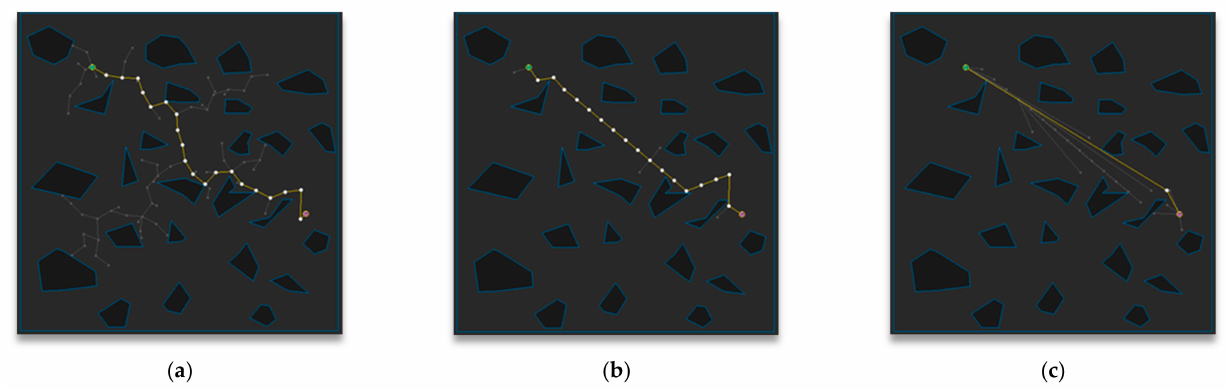
Figure 14. Experimental result of Map 4: ( a ) RRT; ( b ) RRT-Connect; ( c ) the proposed algorithm.